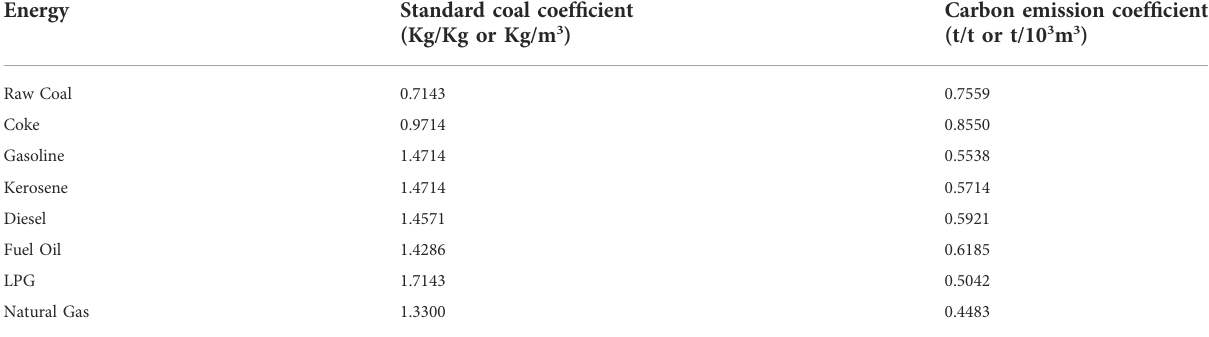
TABLE 1 Coef fi cient of the eight energy